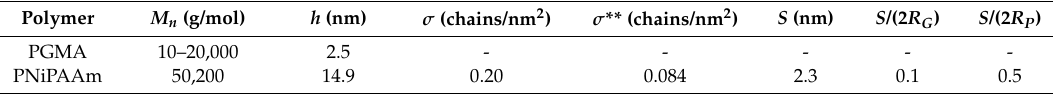
Table 1. Dry layer parameters (number-average molecular weight M n , thickness h , grafting density σ , grafting distance S , and corresponding brush criteria) of polymer films, which were used in this study.